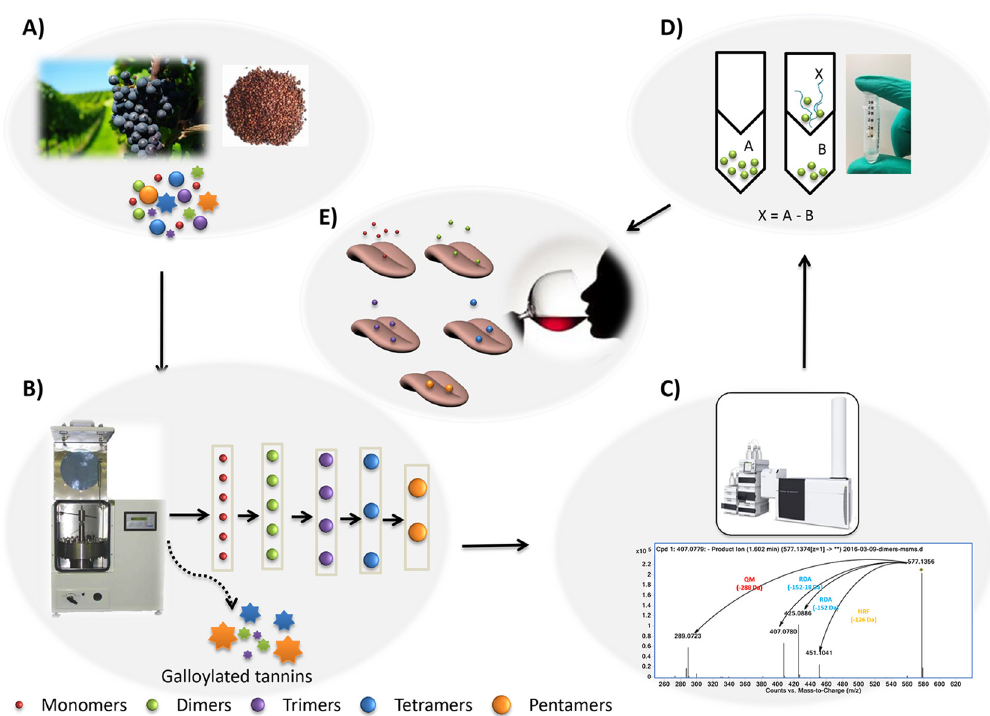
Fig 2. General procedure of experimental design: (A). Tannins were extracted from grape seeds; (B). Technique of CPC fractionated tannins according to their DP size; (C). Purified compounds were identified by UHPLC-HRMS; (D). Salivary protein binding abilities of purified oligomers were assessed by measuring difference between tannins with and without saliva; (E). Astringency intensities of monomeric, dimeric, trimeric, tetrameric and pentameric tannins in model wine solution were